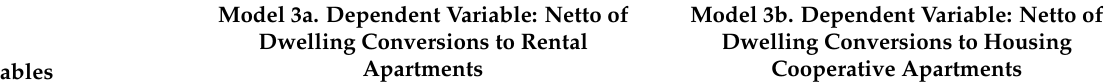
Table 6. Dynamics of dwelling